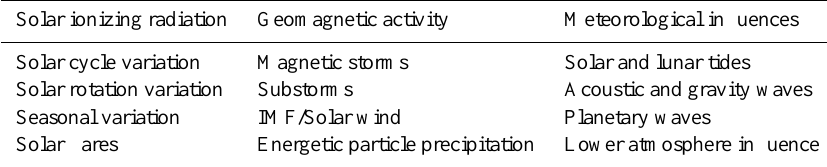
Table 2. Possible drivers of ionospheric variability of F layer.